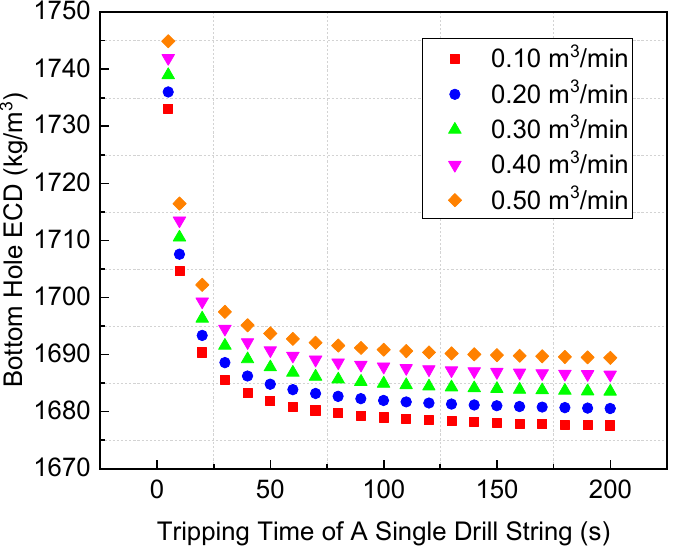
Figure 19. Variation of bottom hole ECD with tripping time of a single drill string.